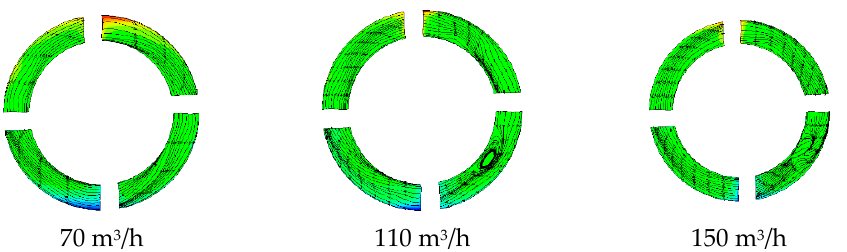
Figure 13. The streamline distribution of the middle section of the middle section of the first impeller wheel.